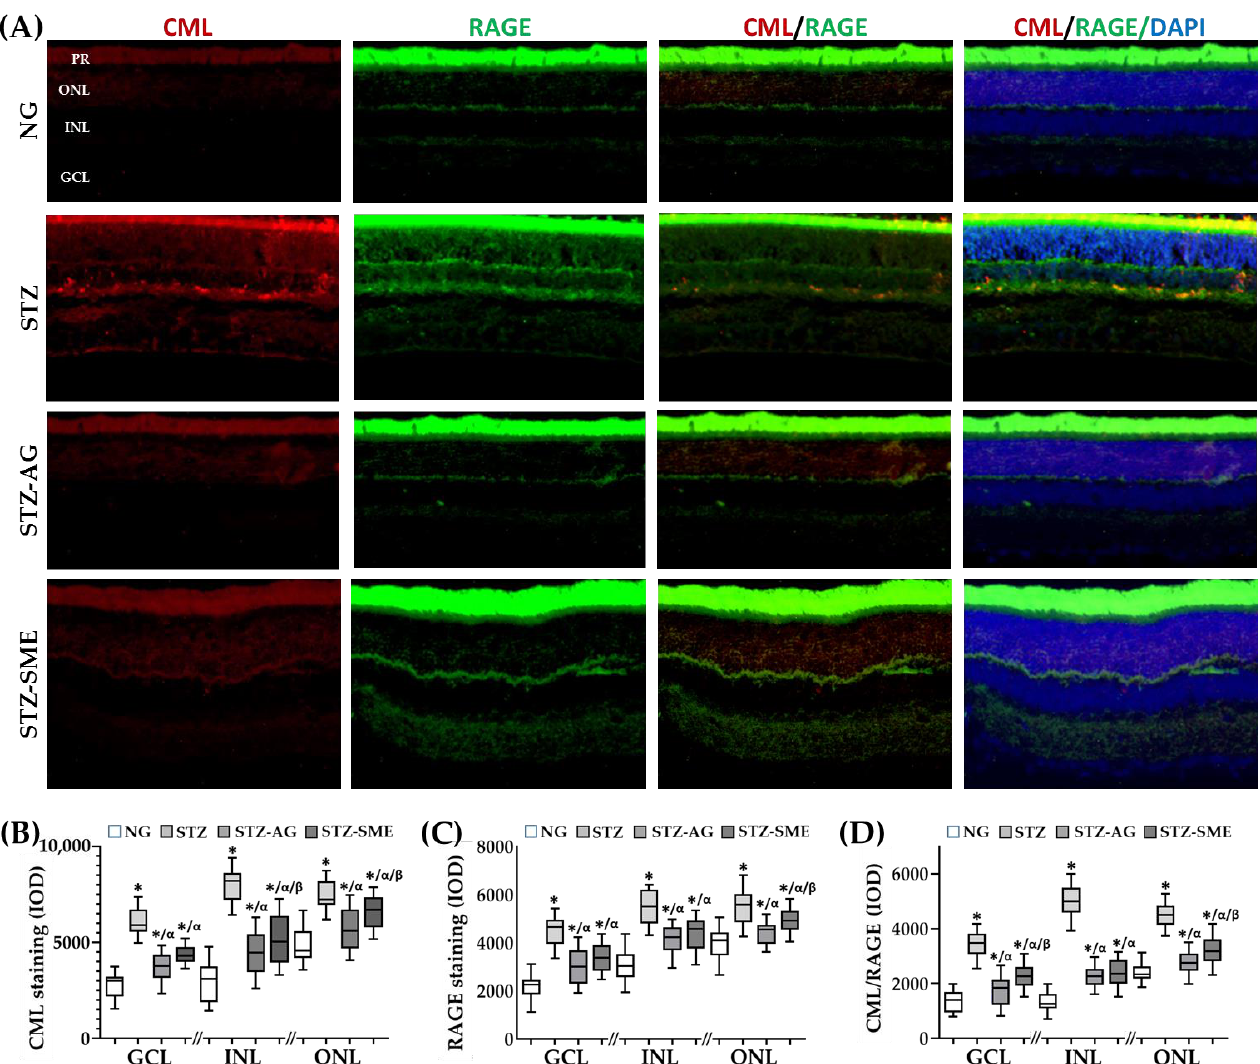
Figure 1. Effect of spinach methanolic extract (SME) on carboxymethyl-lysine (CML), receptor for advanced glycation end products (RAGE), and CML–RAGE interaction (CML/RAGE) in the retina of streptozotocin-induced diabetic rats (STZ). ( A ) The distribution for CML, RAGE, and CML/RAGE stainings are shown in retinas of normoglycemic rats (NG), STZ, treated with aminoguanidine (STZ-AG), and treated with SME (STZ-SME). ( B – D ) show the integrated optical density (IOD, lum/pixel 2 ) in a box-and-whisker plot in the ganglion cell layer (GCL), inner nuclear layer (INL), and outer nuclear layer (ONL) for each immunostaining. * p < 0.01 compared to NG; α p < 0.01 compared to STZ; and β p < 0.01 compared to STZ-AG. Magnification 200×. n = PR = photoreceptors.